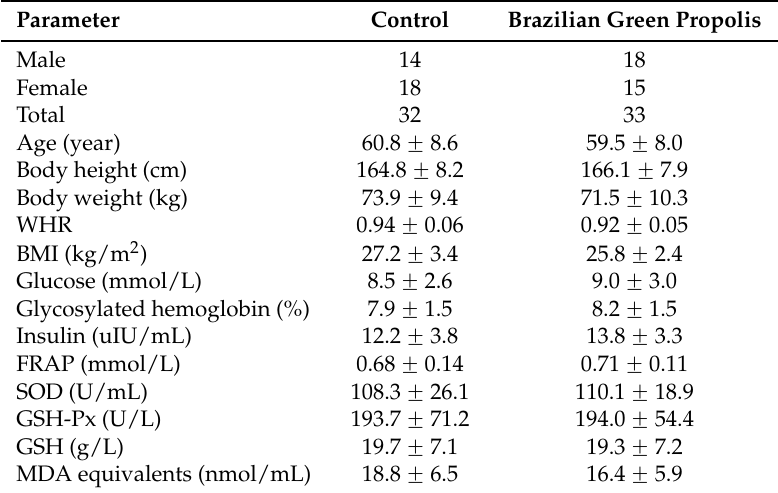
Table 1. General characteristics of the subjects at baseline.